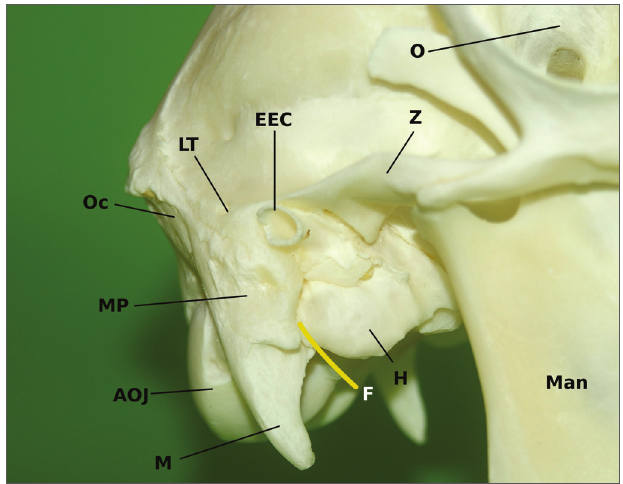
Figura 1. Crânio de ovelha mostrando o ouvido direito. O conduto auditivo externo (EEC) é cranialmente separado do crânio pelo zigo- ma (Z), que se expande até a linha temporal (LT). Abaixo, é possível visualizar a grande bolha do hipotímpano (H). O plano mastoideo (MP) e o processo mastoideo (M) podem ser visualizados. O curso do nervo facial está em amarelo (F). Man = Mandíbula, O = Órbita, AOJ = Articulação atlanto-occipital, Oc = Occípito.